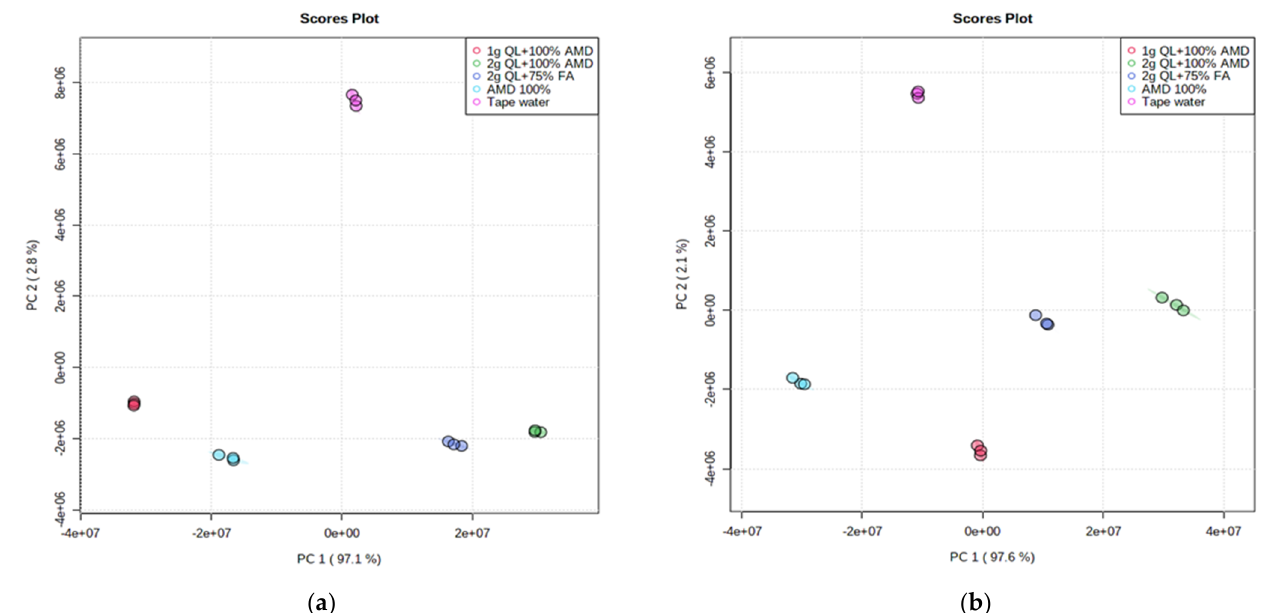
Figure 1. 2D Principal component (PCA) analysis score plot from liquid chromatography linked to mass spectrometry data of samples from Marykies ( a ) and Royal ( b ) potato tuber samples. Different colors denoted different treatments: tap water (T1): purple, AMD 100% (T2): light blue, 1 g QL + 100% (T3): red, 2 g QL + 100% AMD (T4): green and 2 g QL + 75% FA (T5): dark blue, respectively.